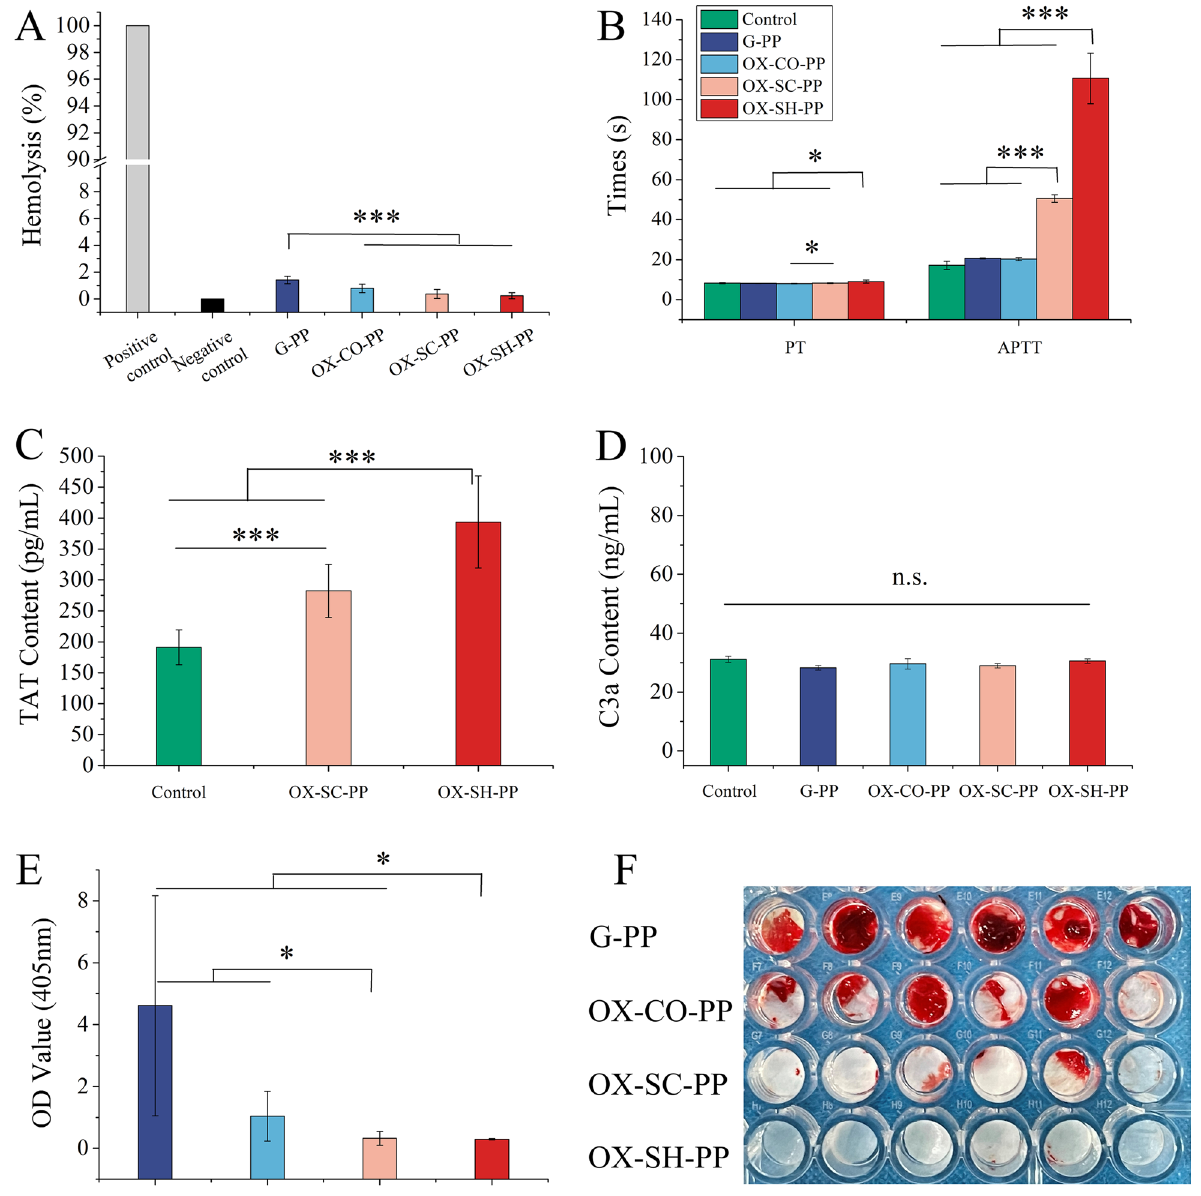
Fig. 3 A Hemolysis effect of G-PP, OX-CO-PP, OX-SC-PP and OX-SH-PP; B APTT and PT for plasma after incubation with PPs; C The TAT content of plasma after incubation with PPs; D The concentrations of C3a in the plasma after treatment with PPs. The amount ( E ) and images F of thrombus generated on the surface of PPs after recalcified whole blood clotting. (*p < 0.05, **p < 0.01, ***p <